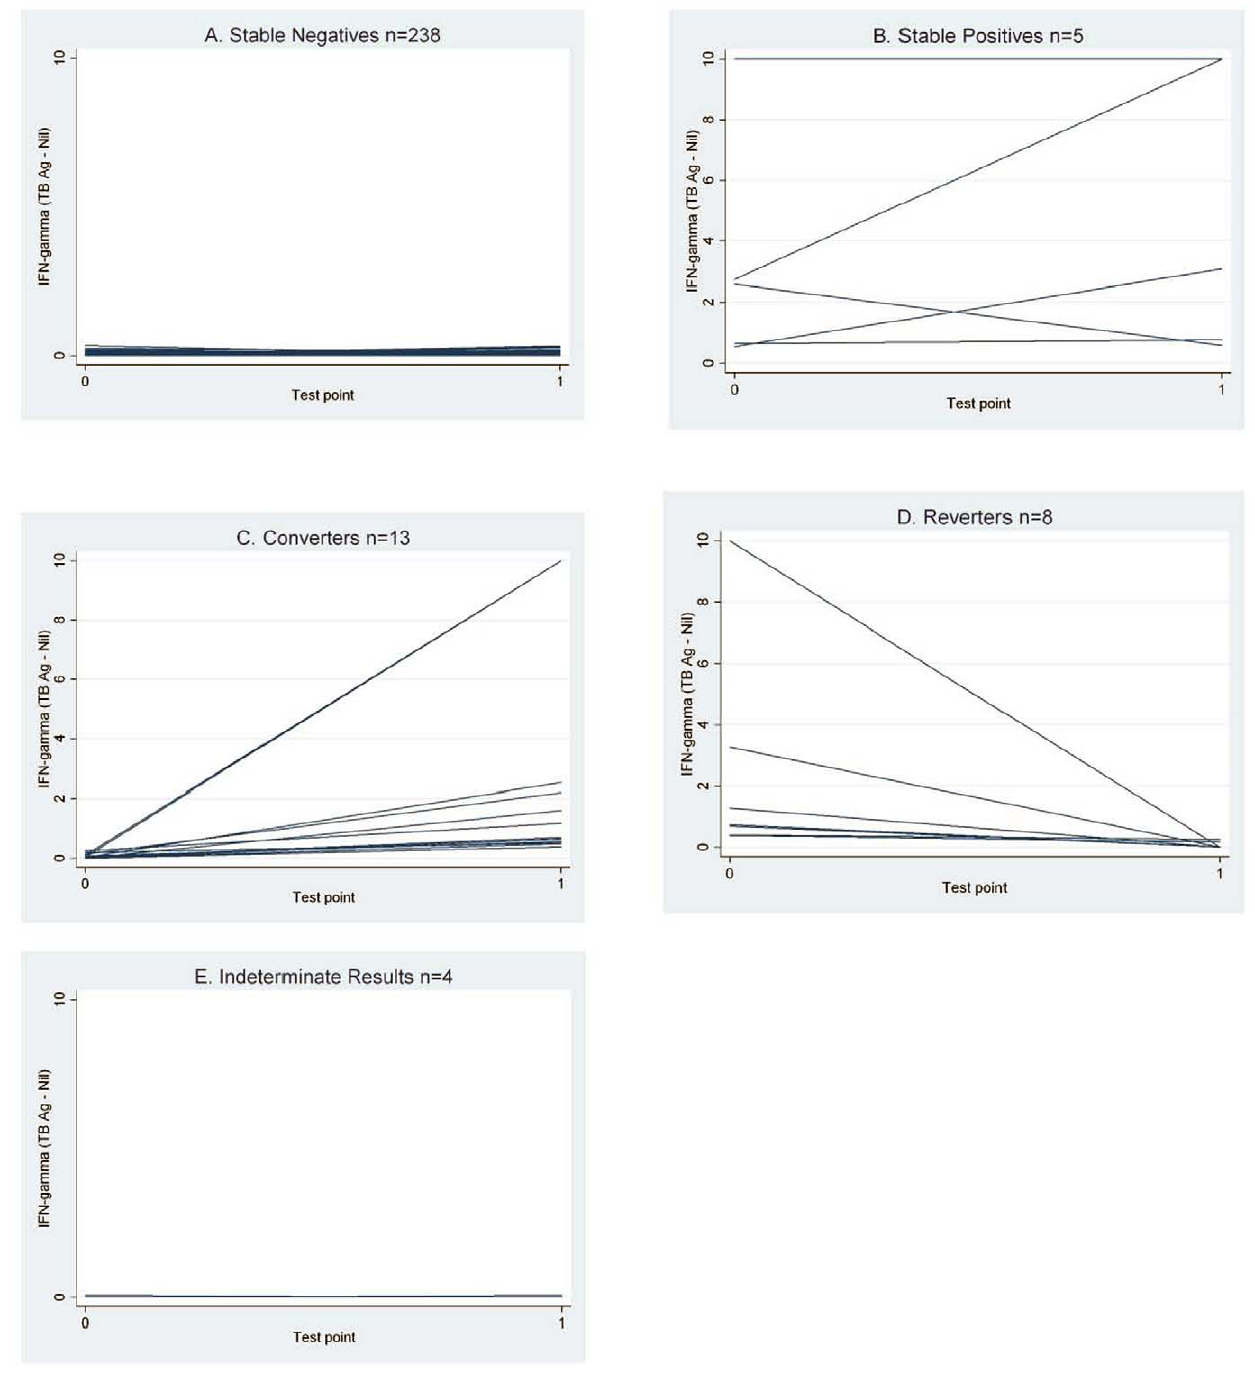
Figure 1. Trajectories of continuous IFN-gamma values from time 1 to time 2. Trajectory of continuous interferon-gamma response over time within each participant (TBAntigen- TB Nil, IU/ml). HCWs have been stratified by overall QFT patterns and we have presented trajectory plots for each category of QFT pattern: stable negatives, stable positives, converters, reverters, and indeterminate results. doi:10.1371/journal.pone.0054748.g001 biggest change in INF-g values is seen among converters (median change in IFN-g= 0.67IU/ml) and reverters (median change in IFN-g = 2 1.01 IU/ml). Stable negatives experienced a median value of 0 change while stable positives reported a small median increase (0.13 IU/ml).